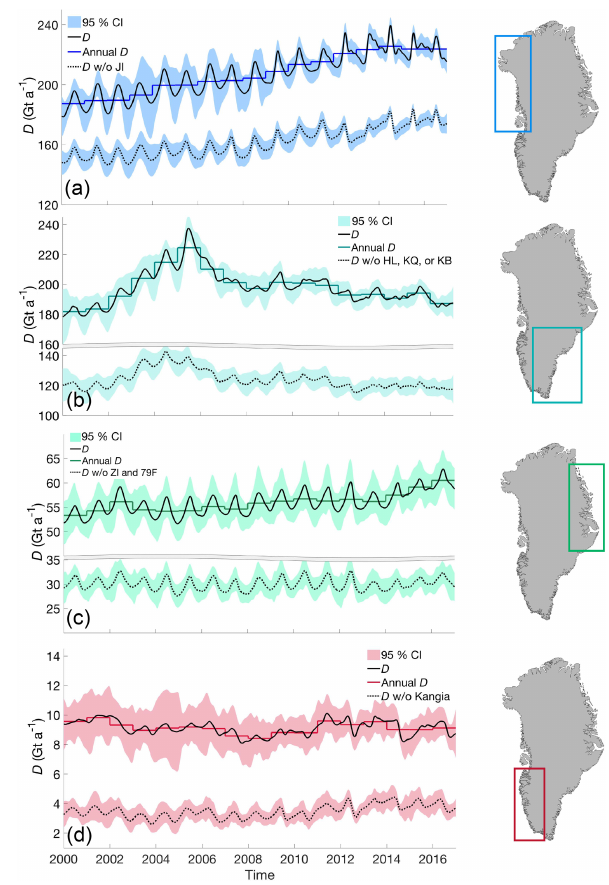
Figure 3. Net regional D including (solid line) and excluding (dashed line) the dominant glaciers in each region, with shad- ing representing the 95% confidence interval. From top to bottom these regions include the northwest (a) , plotted with and without Jakobshavn (JI), the southeast (b) with and without Helheim (HL), Kangerdlugssuaq (KQ), and the main trunk of Køge Bugt (KB), the northeast (c) , with and without Zachariæ Isstrøm (ZI) and 79 North (Fjorden) Glacier (79F), and the southwest (d) with and without Kangia